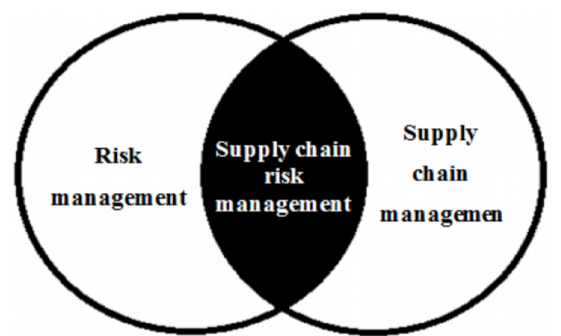
Figure 1. Supply chain risk management adapted from (Vilko,